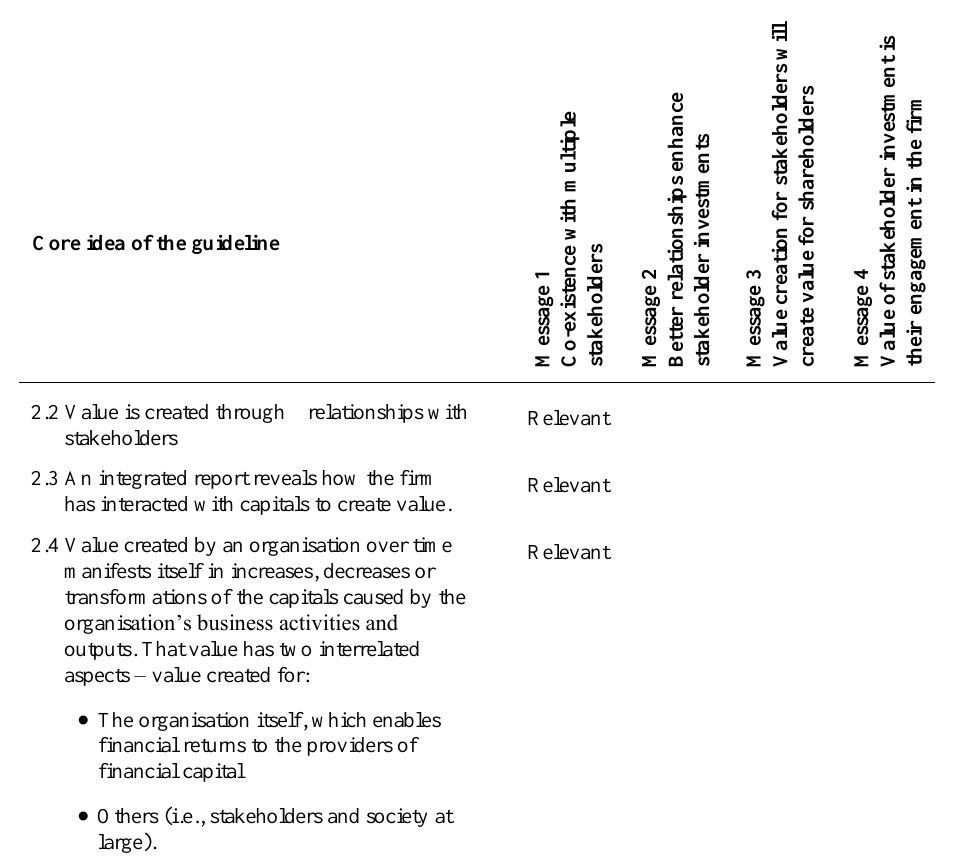
Table 1: Relevance of Guidelines to Four Messages